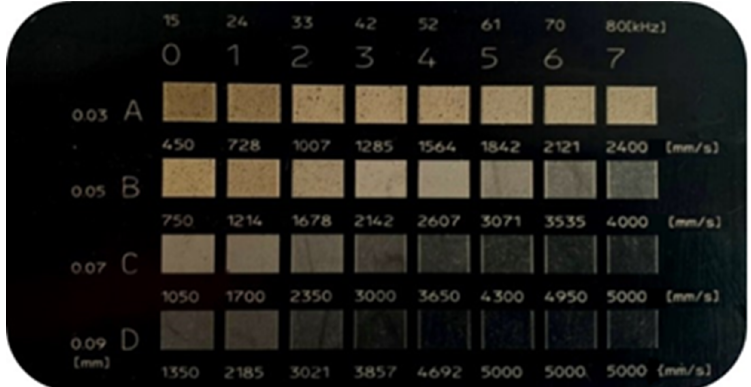
Figure 3. An exemplary matrix of marking of individual graphic fields for specific parameters of the laser beam (S7). ( A – D )—width of the path (from 0.03 to 0.09 mm); ( 0 – 7 )—frequency of the beam pulses (from 15 to 80 kHz); speed (from 450 to 5000 mm/s).